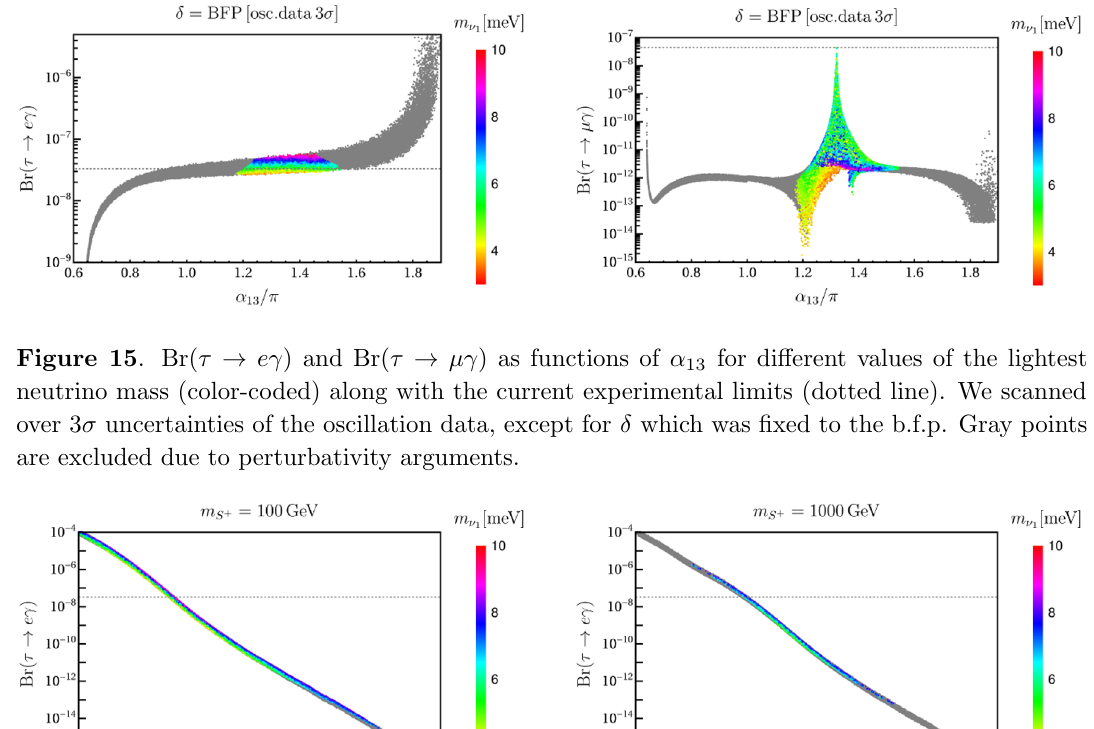
e(cid:13) ) as function of m N for di(cid:11)erent values of m !